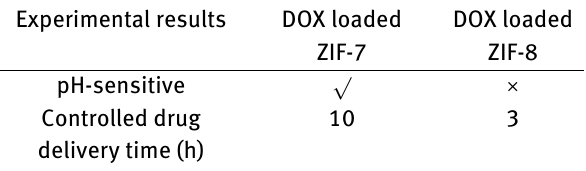
Table 7: Experimental results of 2 groups